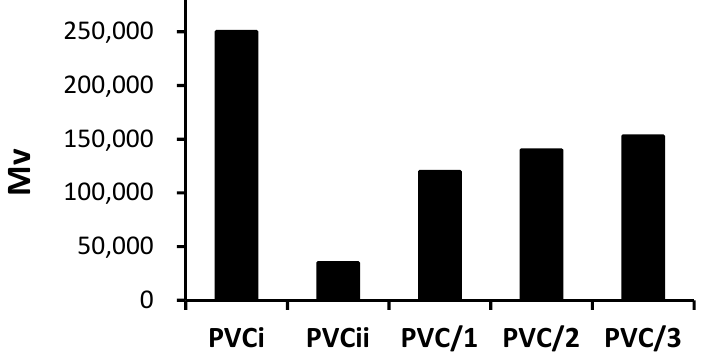
Molecules 2019 , 24 , 2396 Figure 9. E ff ect of irradiation on the polyene index ( I C = C ) of the PVC films. Figure 9. Effect of irradiation on the polyene index ( I C=C ) of the PVC films.